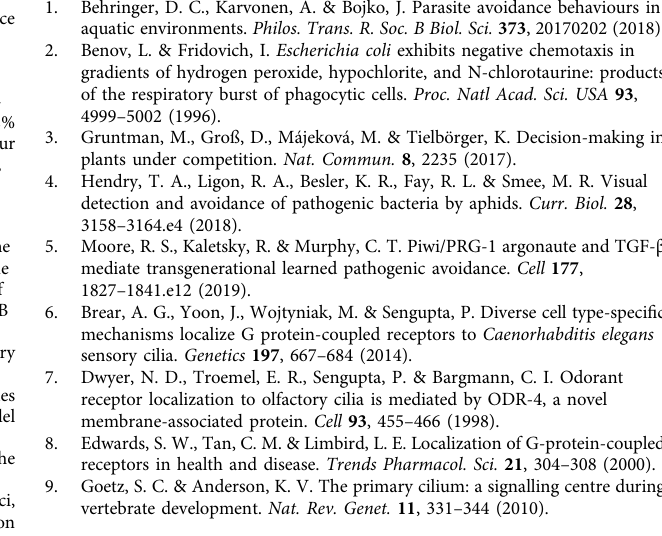
Table 2 56,57 . Primers and guide RNAs used to make the CRISPR/Cas9 and extrachromosomal array strains are listed in Supplementary Table 3. Maintenance of C. elegans was performed using standard procedures 58 .